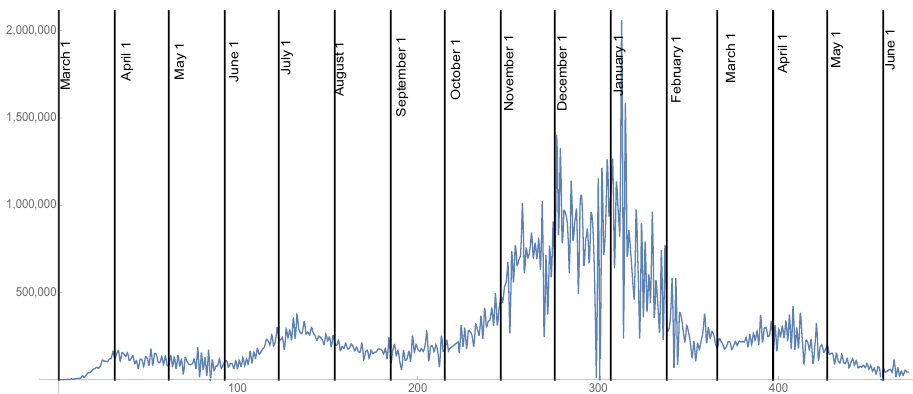
Figure 3. The transmission rate before the last date of reported daily cases, as in (6) for the